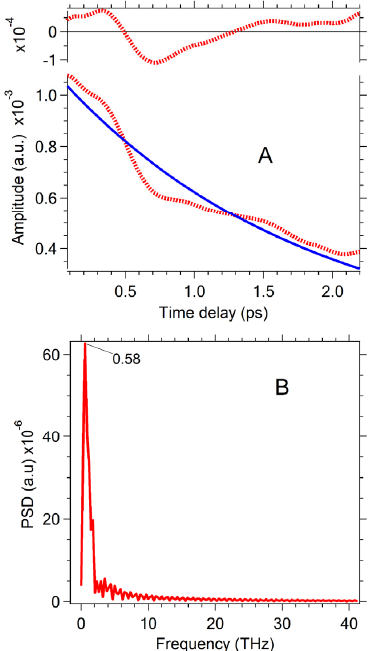
Figure 6. ( A ) Decay of the CWT amplitude corresponding to the coherent LO phonon. Pump fluence is 0.106 mJ/cm 2 . The blue solid line indicates the exponential fit: exp( − t / τ CWT ) The time decay τ CWT is equal to 1.8 ± 0.2 ps. ( B ) FFT of residuals shown in Figure 6A.